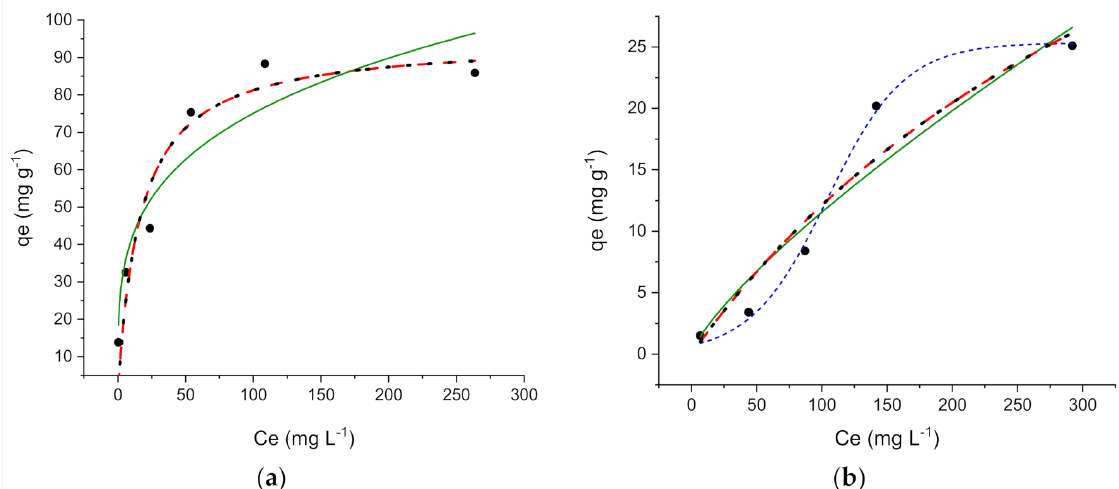
Figure 4. Adsorption profiles Langmuir ( ), Freundlich ( ), Brunauer-Emmett-Teller BET (.......), and sigmoidal ( ) for Ofloxacin (OFL) on ( a ) ZIF-8 and ( b ) Zn 3 (BTC) 2 . (Experimental conditions: MOF (metal-organic framework) 10 mg, 20 mL OFL solution from 8 to 305 mg L − 1 ).